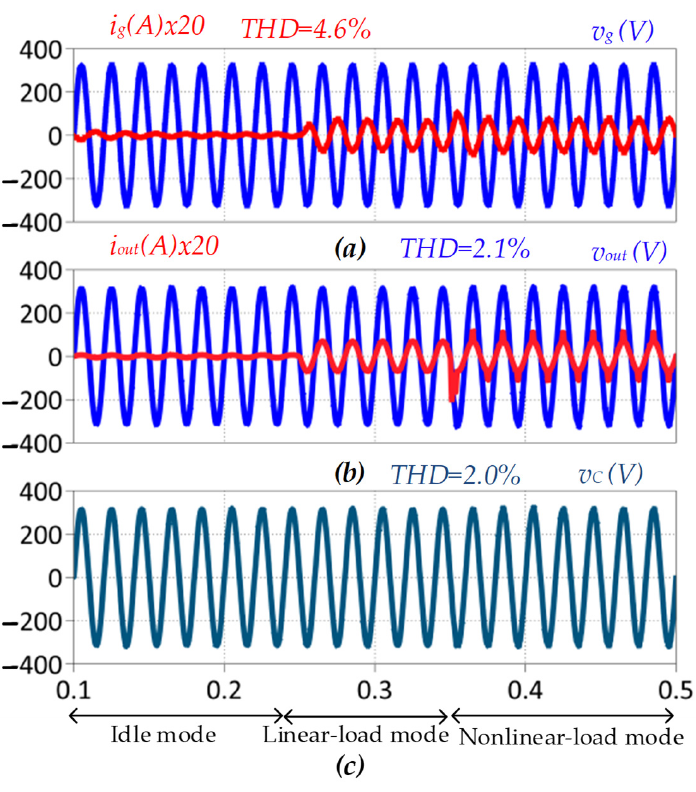
Figure 9. Voltage and current shape transitions at the main grid ( a ), output ( b ), and filter capacitor ( c ) with k out = 0.2 and k c = 0.8 in idle mode, linear load, and nonlinear load.